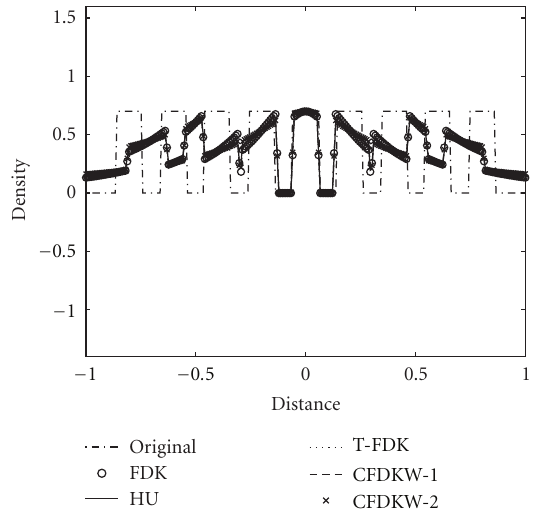
Figure 9: Illustration of axial intensity drop in full-scan recon- structions of Defrise disk phantom, vertical intensity profile of the Defrise disk phantom at z = 0 in Figure